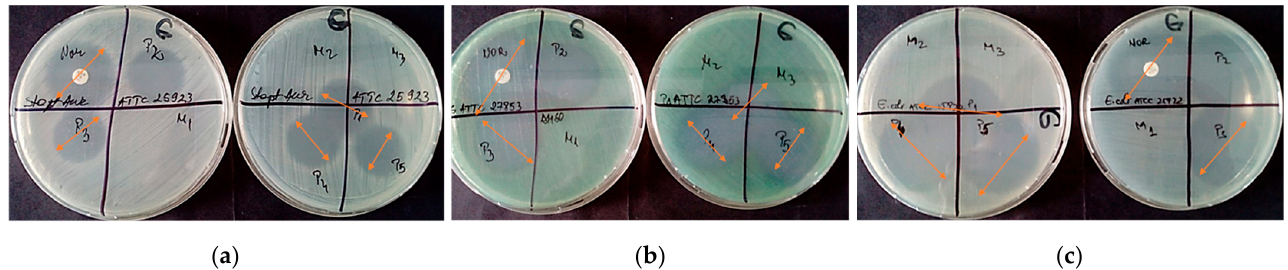
Figure 8. Aspect of the inhibition zones for microorganisms ( a ) Staphylococcus aureus ATCC 25923, ( b ) Pseudomonas aeruginosa ATCC 27853 and ( c ) Escherichia coli ATCC 25922. The samples are denoted P1 = NFLX in water; P2 = NFLX in DMSO; P3 = NFLX in Cremophor EL micellar solution; P4 = NFLX in Pluronic F127 micellar solution; P5 = NFLX in mixed micellar solution, while M1, M2 and M3 are empty micelles of Cremophor EL, Pluronic F127 and mixed micelles, respectively.